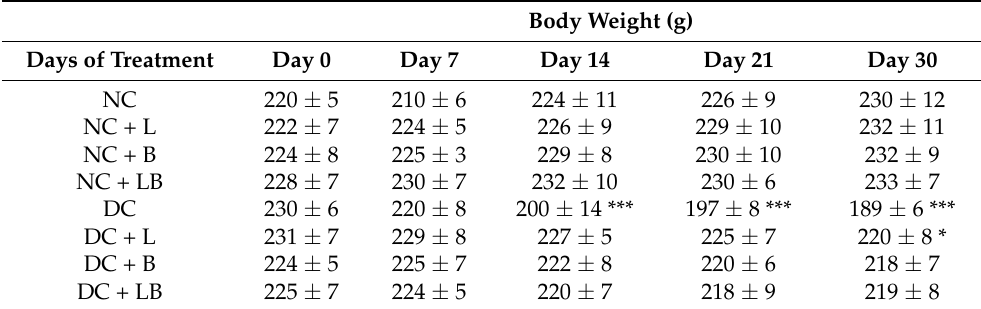
Table 2. Body weight changes of normal and diabetic rats during the experimental period (4 weeks). Body Weight (g)